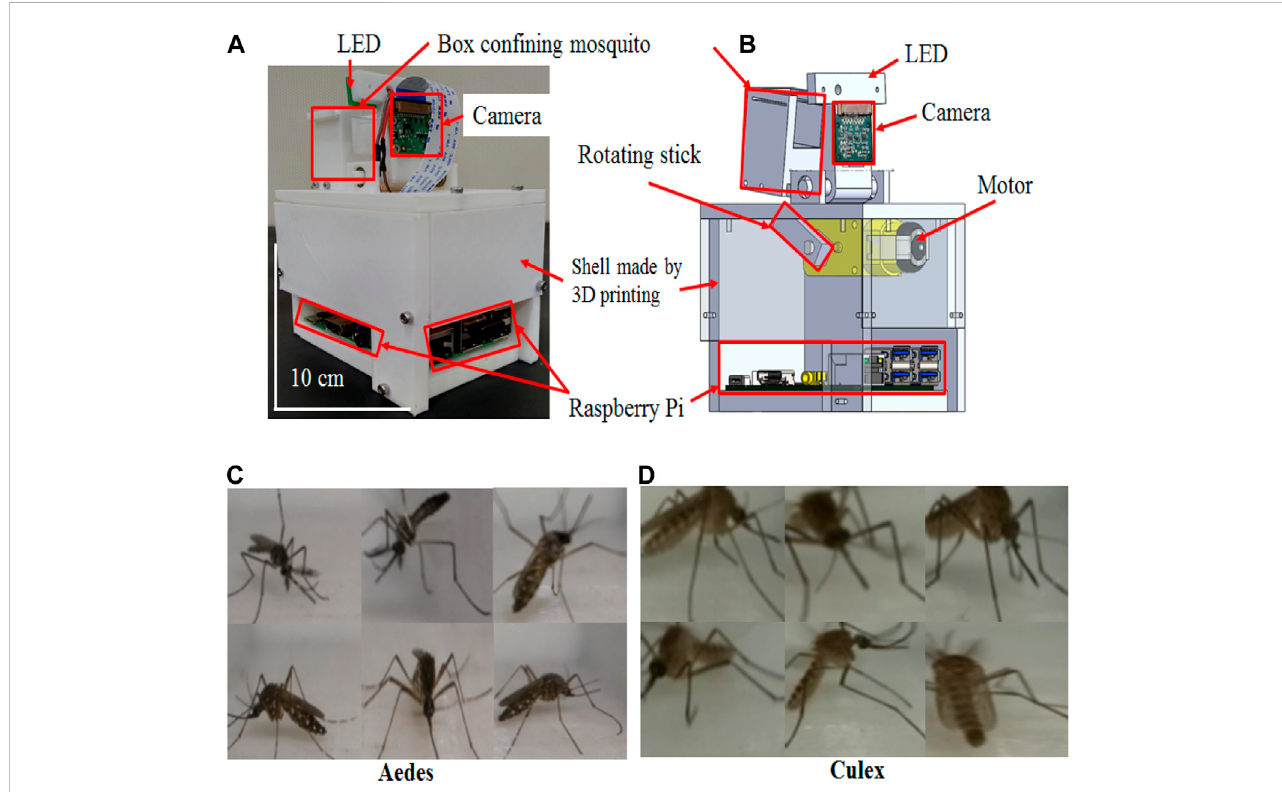
FIGURE 4 Dynamic images were used in the validation phase during the development of the model used in this study. (A) Mechanism of the dynamic mosquito studio. (B) Inside perspective of the dynamic mosquito camera. (C) Actual images of live females of Ae. aegypti and (D) Cx. quinquefasciatus ; females were photographed using a digital camera inside the dynamic mosquito studio based on the Arduino